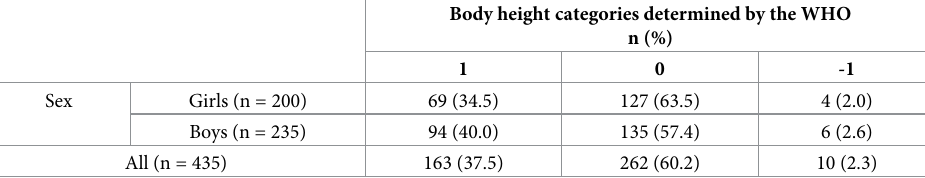
Table 1. The percentage of children taking into account body height categories determined by the WHO.